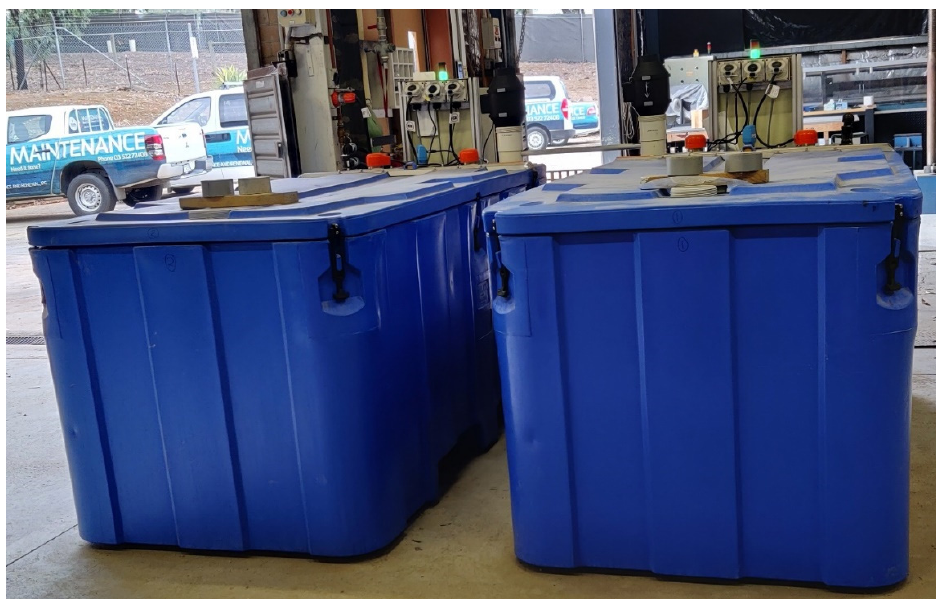
Figure 2. Accelerated weathering tanks.